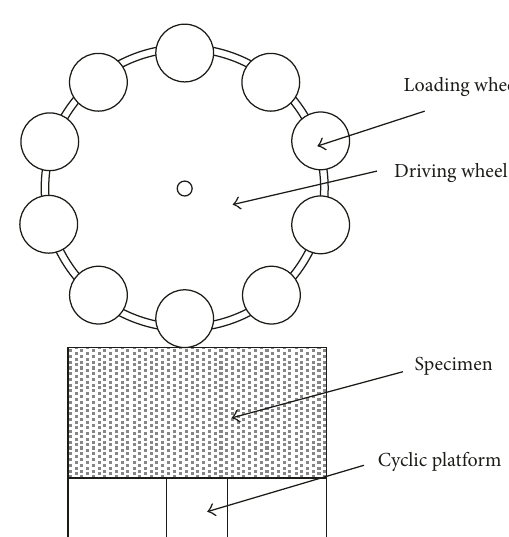
Figure 9: Loading sketch of